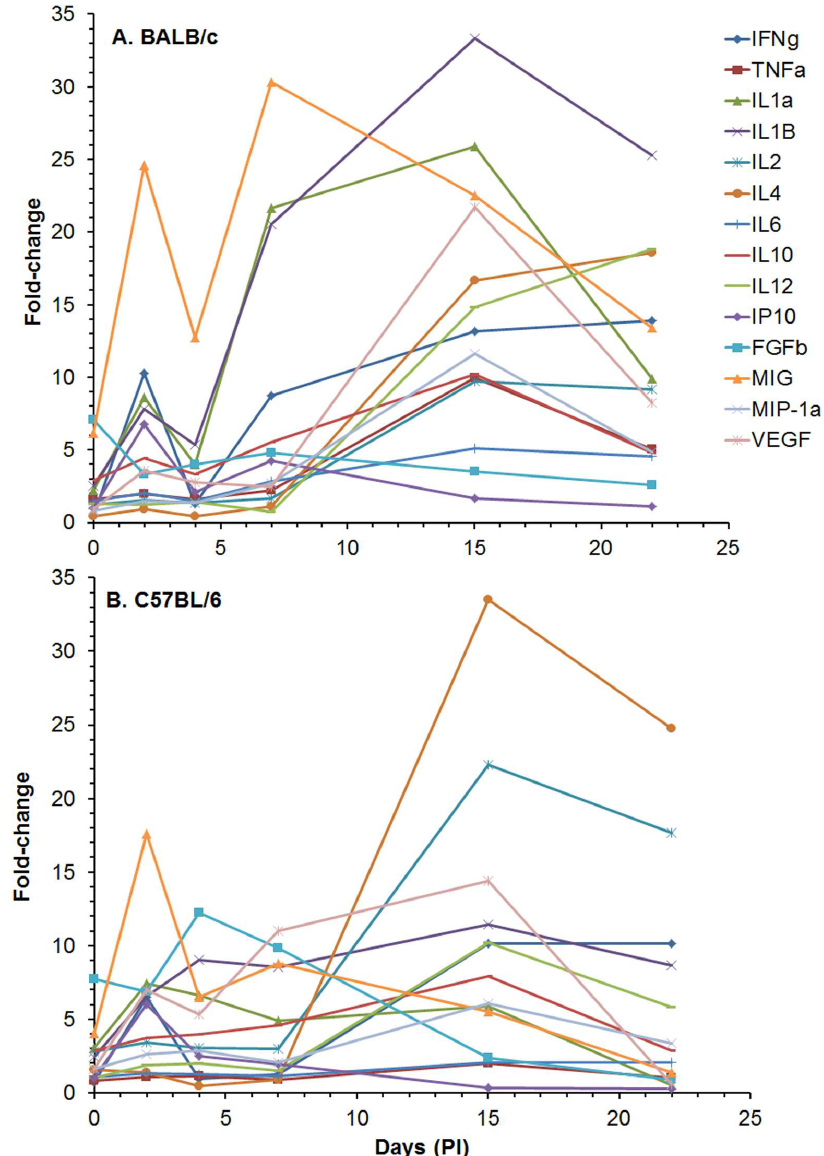
Fig 14. Changes in the amount of cytokines/chemokines in spleen extractsfrom BALB/c and C57BL/6 mice after aerosol exposure to B . pseudomallei K96243. The amount of cytokines/chemokinespresent in spleenextracts (S8 Table) was determined.For changesin cytokine/chemokinelevels in spleen extracts from BALB/c mice (A) , we show changesin levels up to 22 days becausethere were no survivors after that period. We also show changesin cytokines/chemokinelevels in spleen extracts for C57BL/6mice (B) for comparison although they were determinedup to day 91 (S8 Table). For each time point, N = 5 for BALB/c and C57BL/6 mice. Fold-changes in cytokines/chemokineswas determinedby dividingthe amount (S8 Table) present in the spleenextract by the amount present in normal, na ï vemice, where N = 10 for BALB/c and 4 for C57BL/6